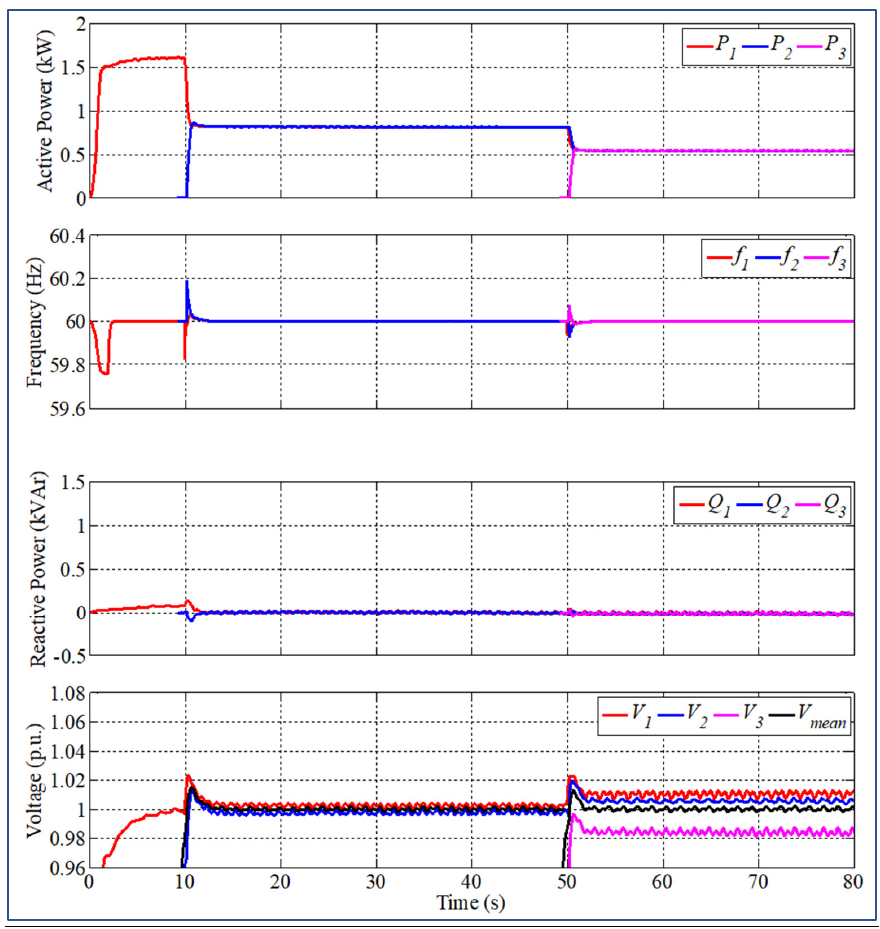
Figure 8. Experimental tests under the optimal set of the secondary control parameter